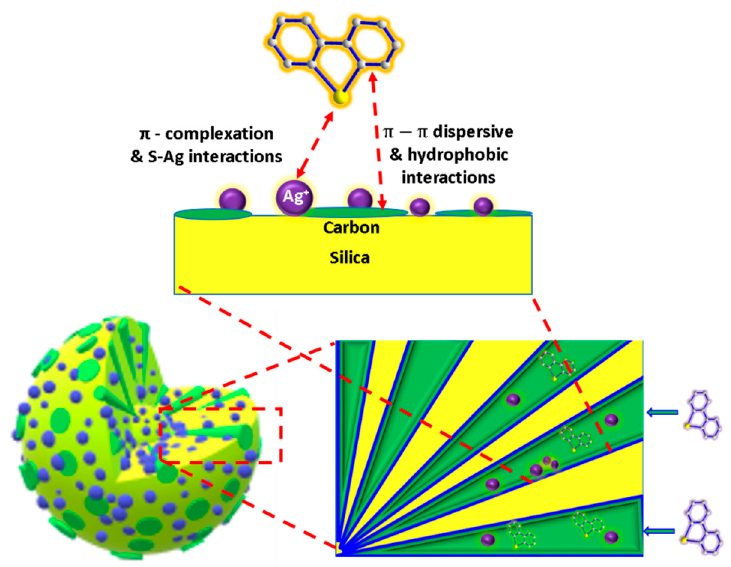
Figure 10. Schematic representation of the synergistic effect of DBT adsorption on dope carbonaceous mesoporous silica supports, Ag/ dendritic mesoporous silica/carbon nanosphere (DMS/CN) structure [155].